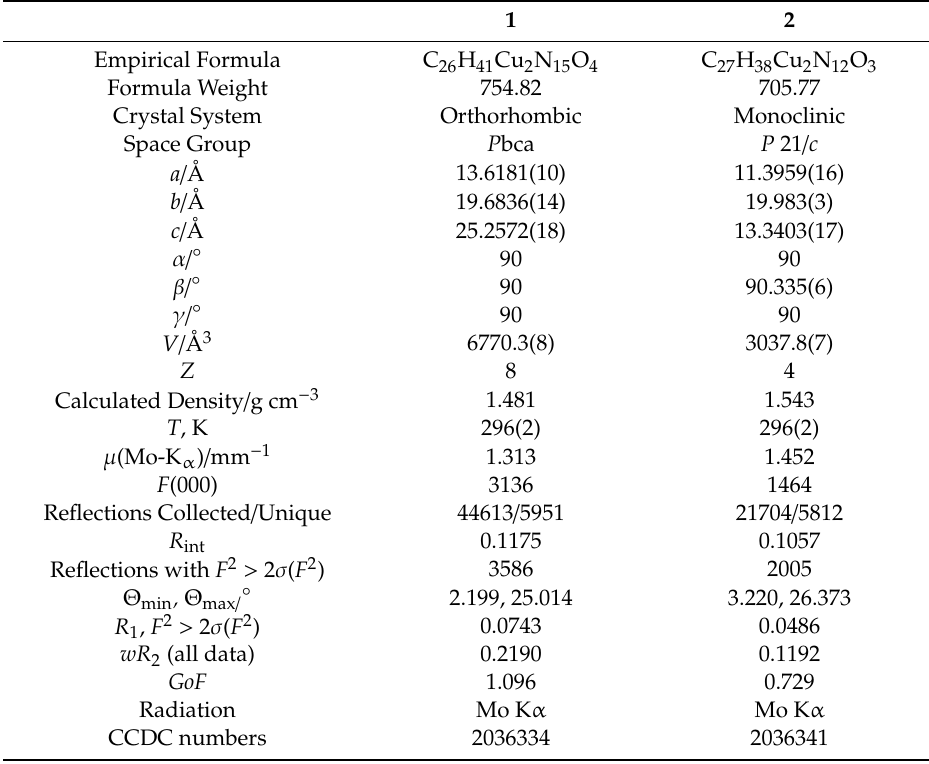
Table 1. Crystal data and structure refinement for 1 and 2